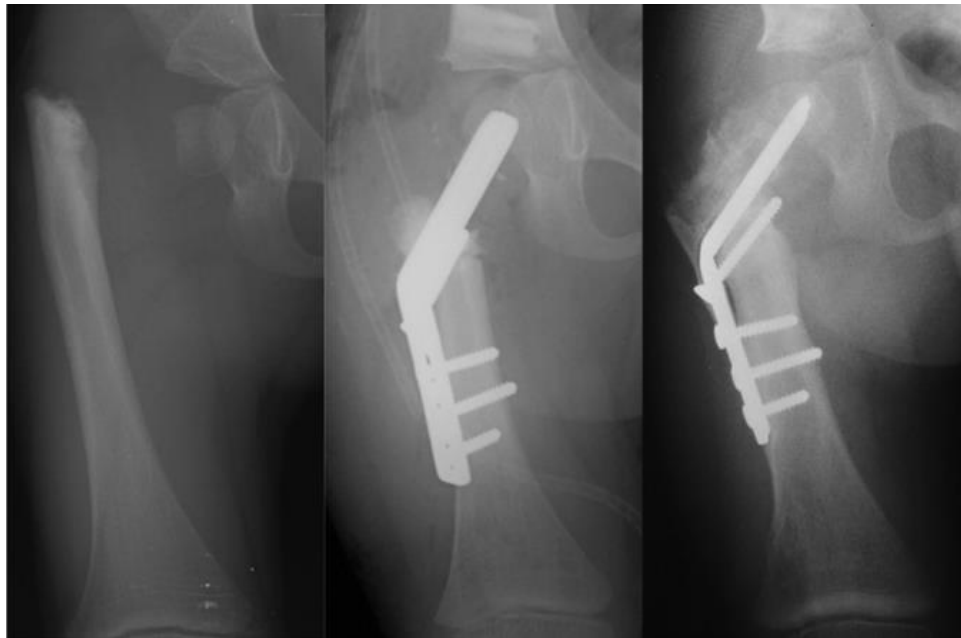
Figure 6. Type 1b CFD preop (left); immediately after SH procedure with fixed angle device and insertion of BMP2 into superior femoral neck (middle); and three months after SH procedure showing ossification of the superior femoral neck in the region of the BMP2 (right).